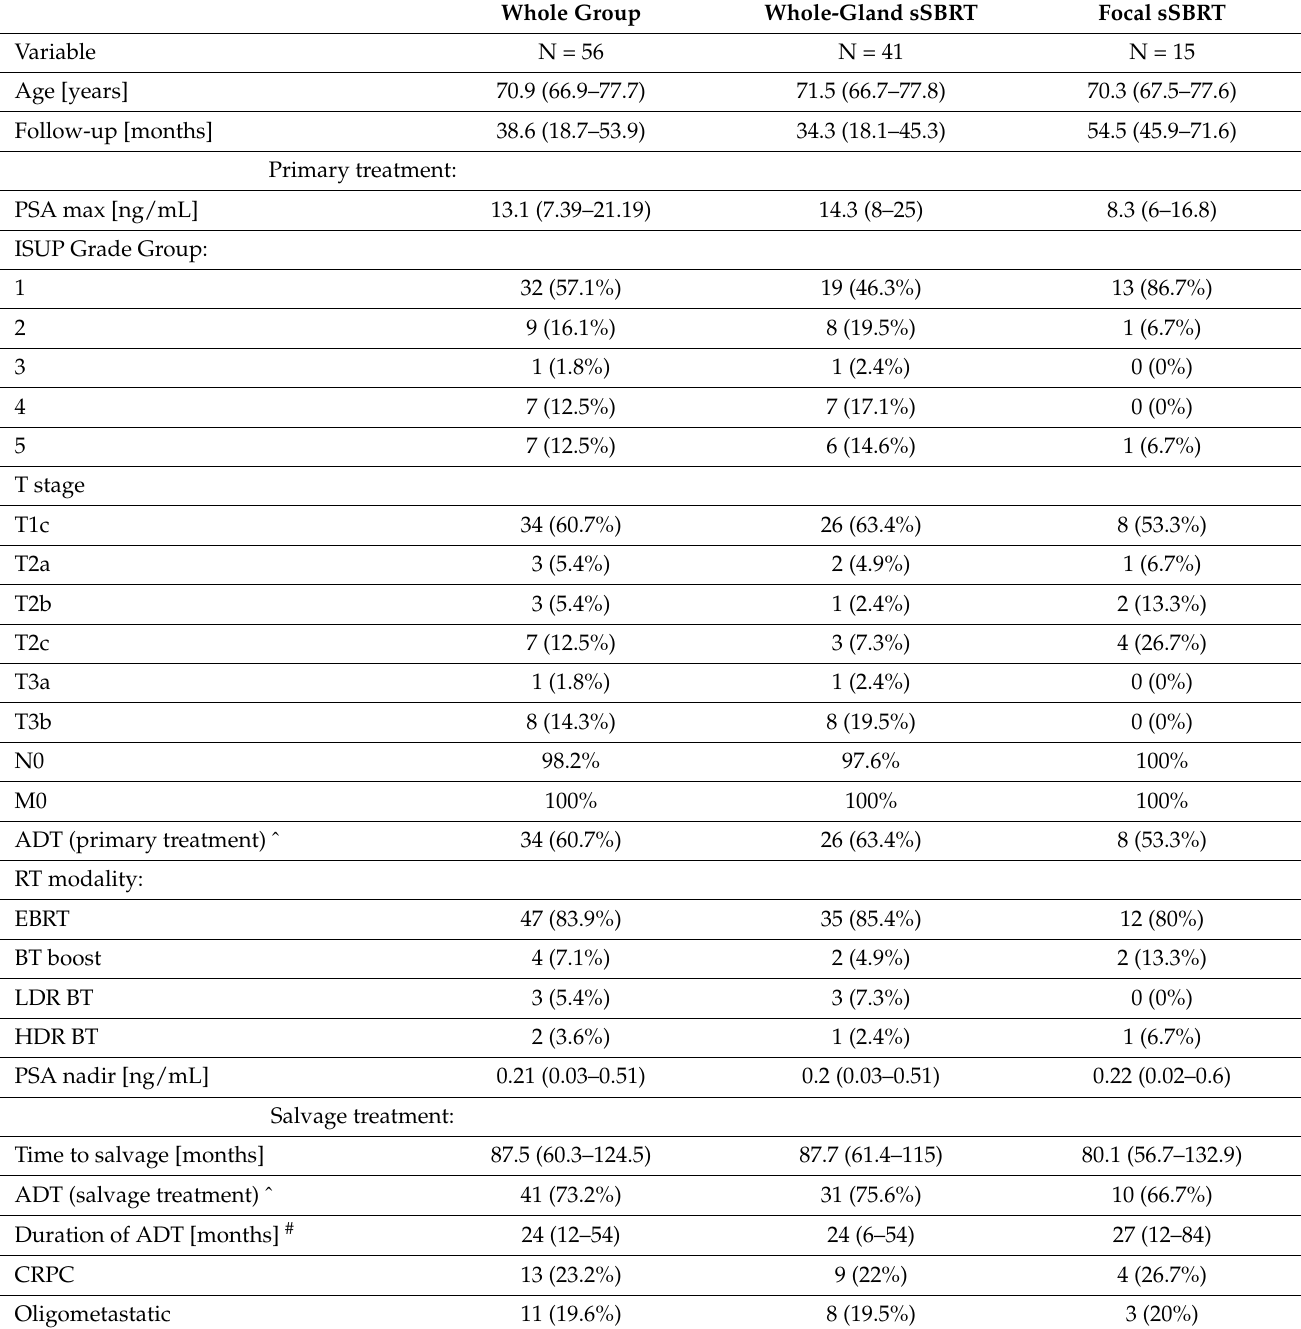
Table 1. Study group description of 56 patients treated with hypofractionated salvage re-irradiation for local post-radiotherapy prostate cancer recurrence. Whole